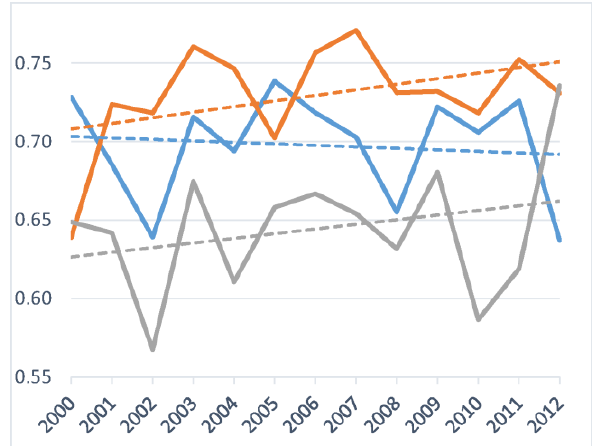
Figure 4. Graphs of the NDVI at the test area, from 2000 to 2013. The NDVI is averaged for test area and by seasons (blue graph – spring, orange – summer, grey -